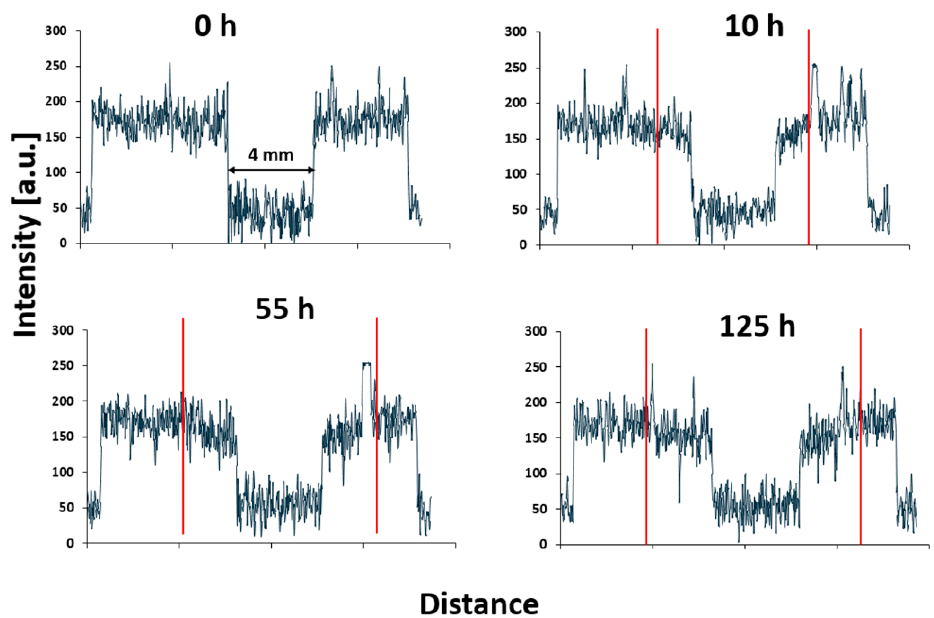
Figure 9. Intensity profiles for sample B taken after 0, 10, 55 and 125 h of exposure to 1 M HCl. The red lines indicate the outer boundaries of the etched volume. The reaction depth was plotted as a function of time for shale samples exposed to HCl acid at parallel and perpendicular configurations (see Figure 10).